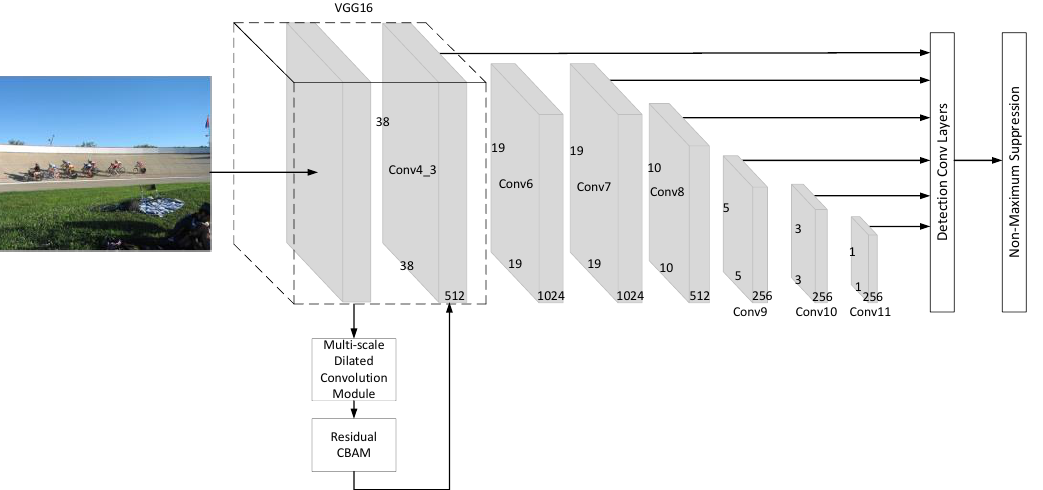
Figure 2. The single-shot object detection with attention mechanism and dilated convolution (AD- SSD).